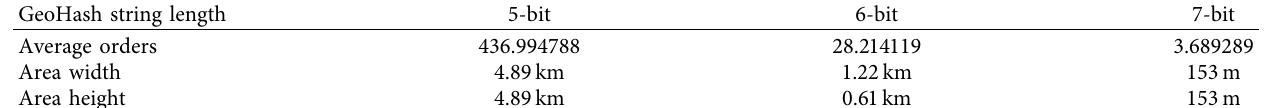
Table 1: Te order information of corresponding GeoHash string